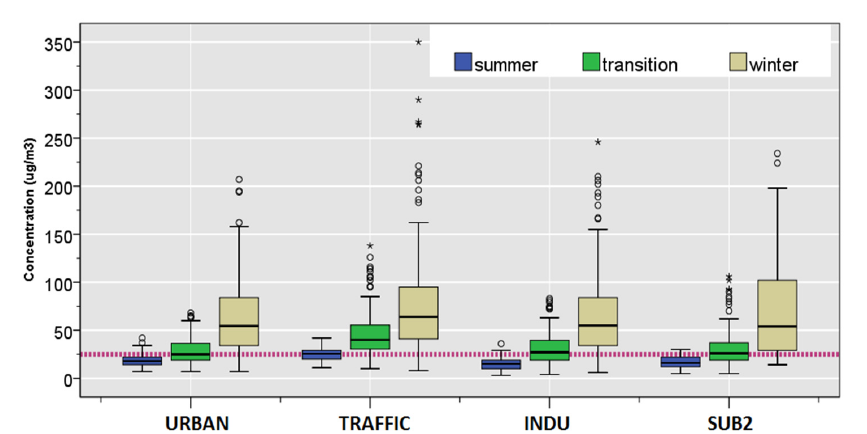
Figure 3. Distributions of daily concentrations of PM 2.5 during summer (June, July, and August); transition (April, May, September, and October); winter (November through March) of PM 2.5 , The dotted line shows the EU standard of 25 µg/m 3